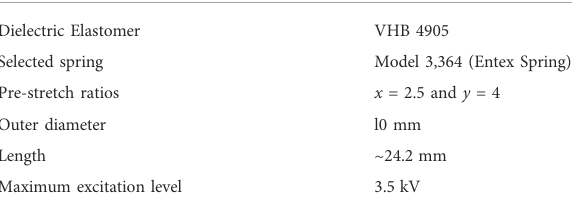
TABLE 3 Design parameters of the optimized spring-roll DE